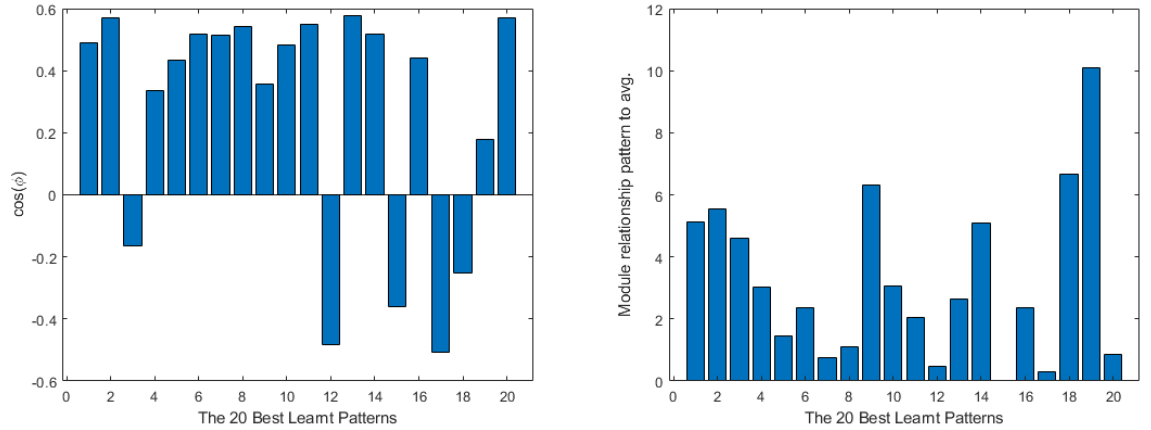
(cid:12) (cid:12) ∂ Loss (cid:12) (cid:12) (cid:12) (cid:12) relationship to the average ∂ W n